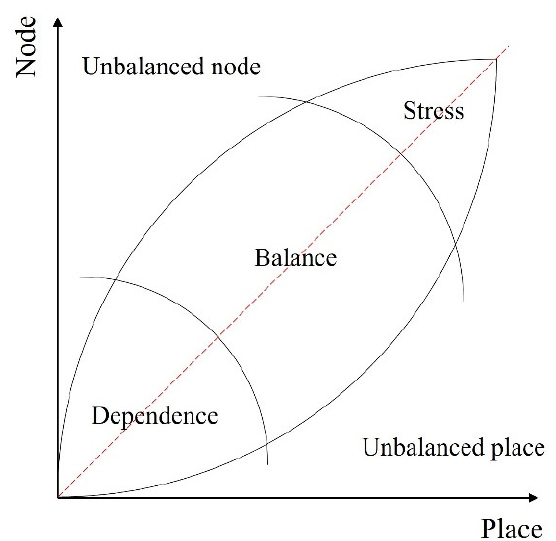
Figure 3. The original node–place model by Bertolini [25].